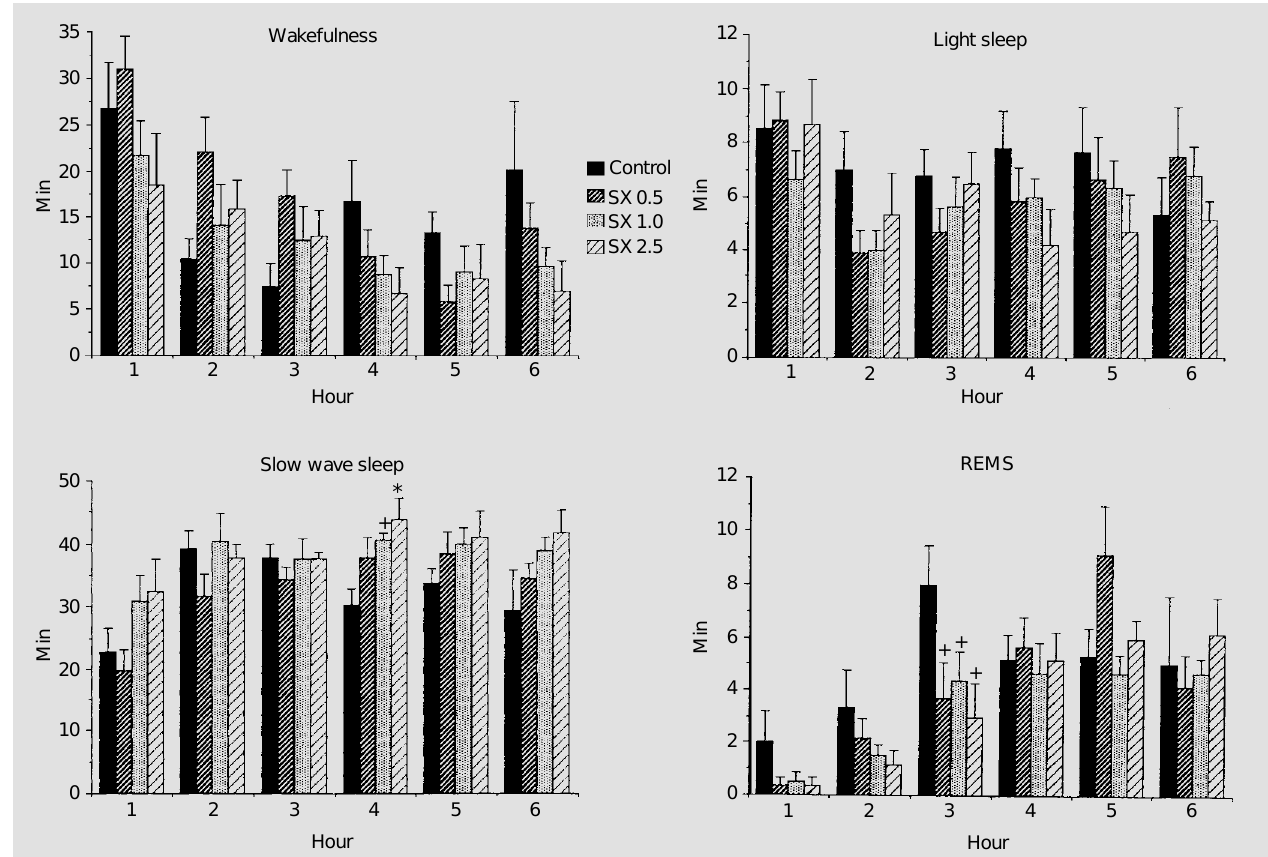
Figure 1 - The effect of SX-3228 (SX) on wakefulness, light sleep, slow wave sleep and rapid-eye-movement sleep (REMS) during the light phase of the light-dark cycle. Ordinate: mean amount in minutes of behavioral state according to EEG criteria. All values are the means (min) ± SEM collected at 1-h intervals. Six animals were in each experimental group. Doses are reported in mg/kg. + P<0.05; *P<0.01 compared to control (Newman-Keuls test).